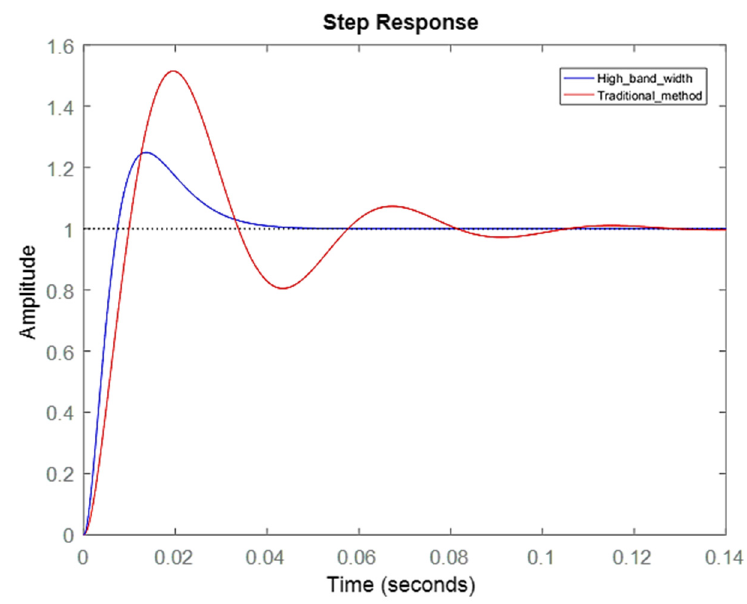
Figure 14. Speed loop frequency response verification.